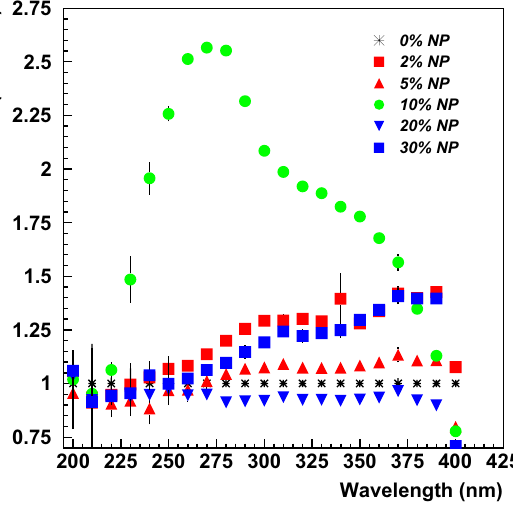
Figure 8. Ratio of responses versus wavelength for 6 sample buttons with various concentrations of LaF 3 :Ce nanoparticles from 2 wt% to 30 wt% (black stars are the 0 wt%